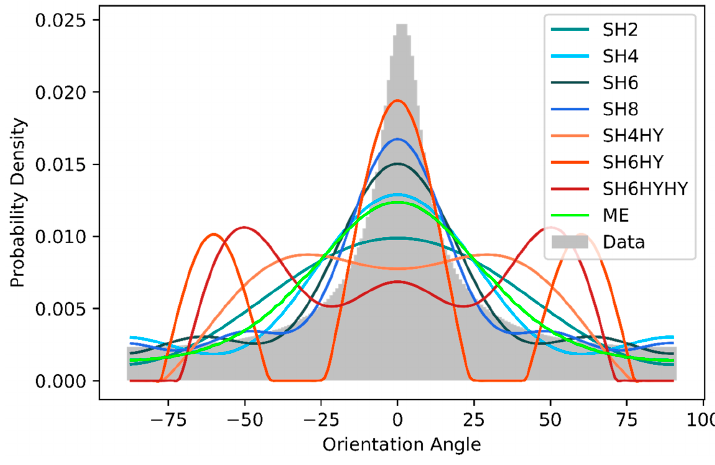
Figure 14. Measured and reconstructed ODFs from [44].